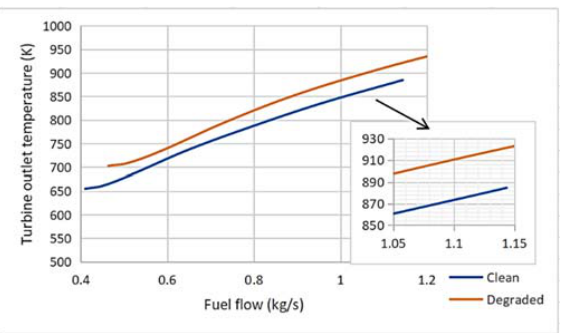
Figure 20. Comparison of the fuel flow to rotor speed relationship between a clean engine and de ‐ graded engine .